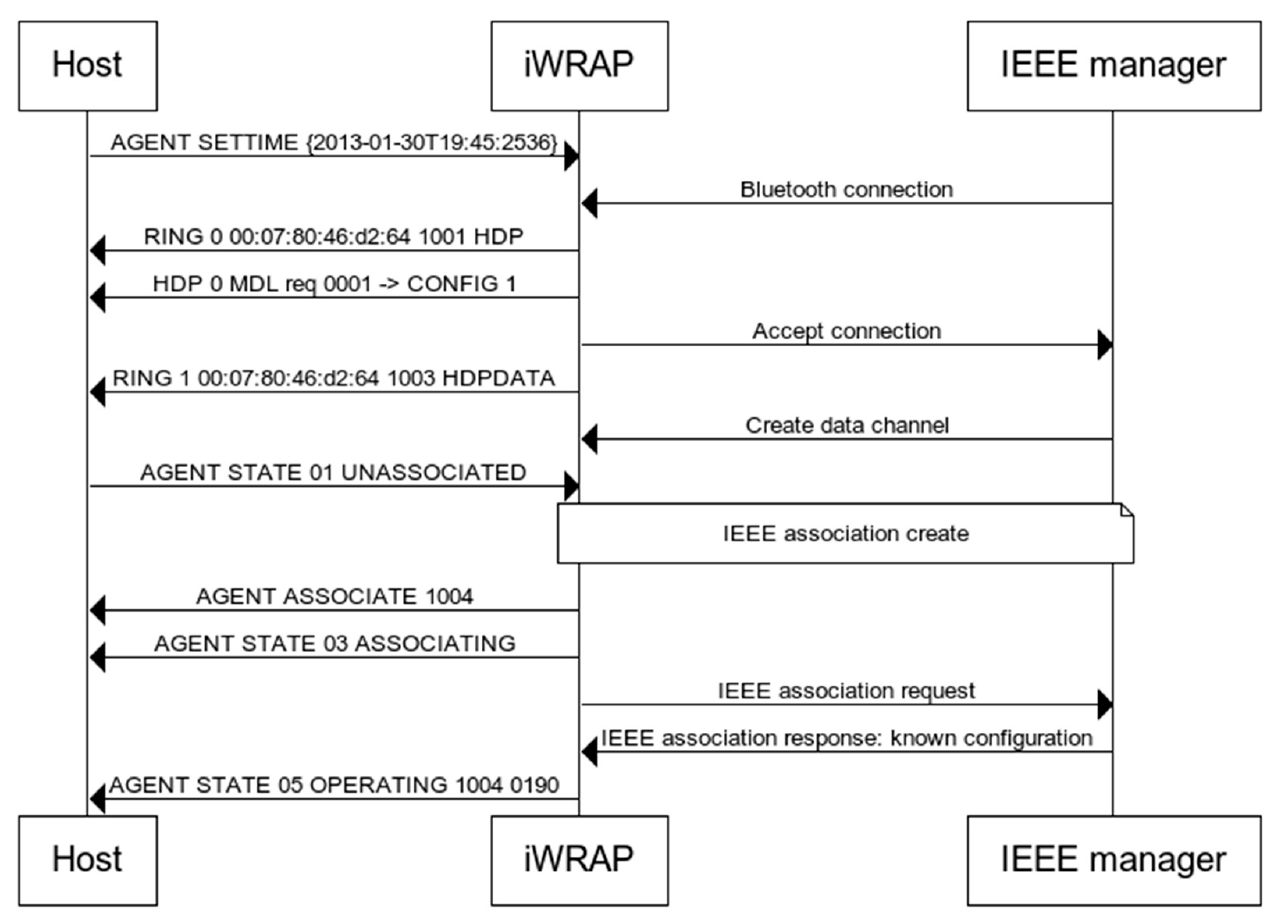
Figure 4. Example of connection establishment sequence between a manager and a SpO2 IEEE agent implemented in the iWRAP firmware. This figure shows the syntax and the order of the commands exchanged.